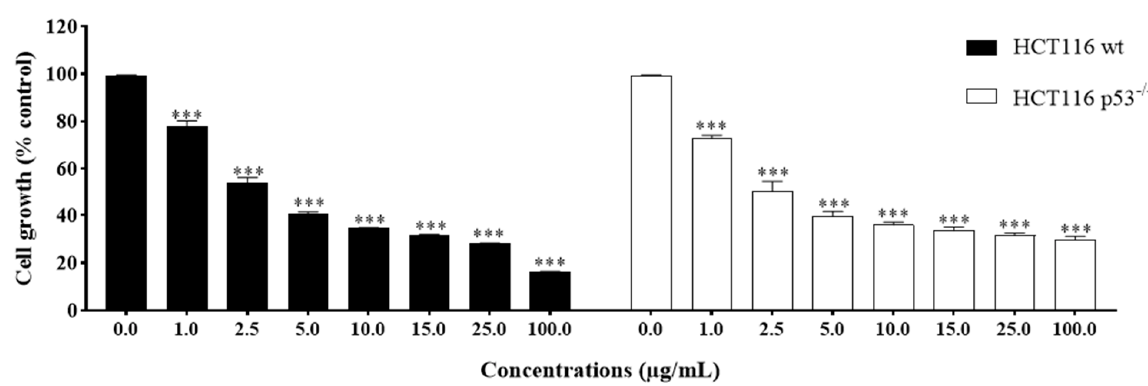
Figure 5. Effect of 5-Fluorouracil on the growth of HCT116 and HCT116 p53 − / − cells. Cells were treated with 0.1% DMSO (control) or the indicated concentrations of the compounds for up to two days. Cell growth was determined in triplicate wells using the MTT cell proliferation assay. Results are expressed as percentage of control and represent the average of three independent experiments ± SEM. Statistical significance is reported by two-way ANOVA post hoc Bonferroni’s multiple comparisons test indicating differences between treated cells and control at 48 h post-treatment (***, p < 0.001). Table 1. IC 50 values of Sal- A, Sal- B, their C8-OH and C9-OH modified derivatives, and 5-Fluorouracil (5-FU). The IC 50 values represent the concentrations that cause 50% inhibition of cell growth at 48 h. Cells were treated with the different compounds for 48 h. All data (mean ± SEM) are the average of three independent experiments performed in triplicate measurements. Cancer cell lines: HCT116 (human colorectal cancer wild type for p53), HCT116 p53 − / − (human colorectal cancer null for p53); NCM460 (normal-like human colon mucosa cell with wild-type p53 ) . ND: not detected. * Approximate IC 50 values. (Approximate IC 50 values for Sal- A and 5-FU were calculated as 100% cell death was not achieved at 100 µg/mL). IC 50 Values ± SEM HCT116 HCT116 p53 − / − Compounds µ g/mL µ M µ g/mL µ M µ g/mL µ